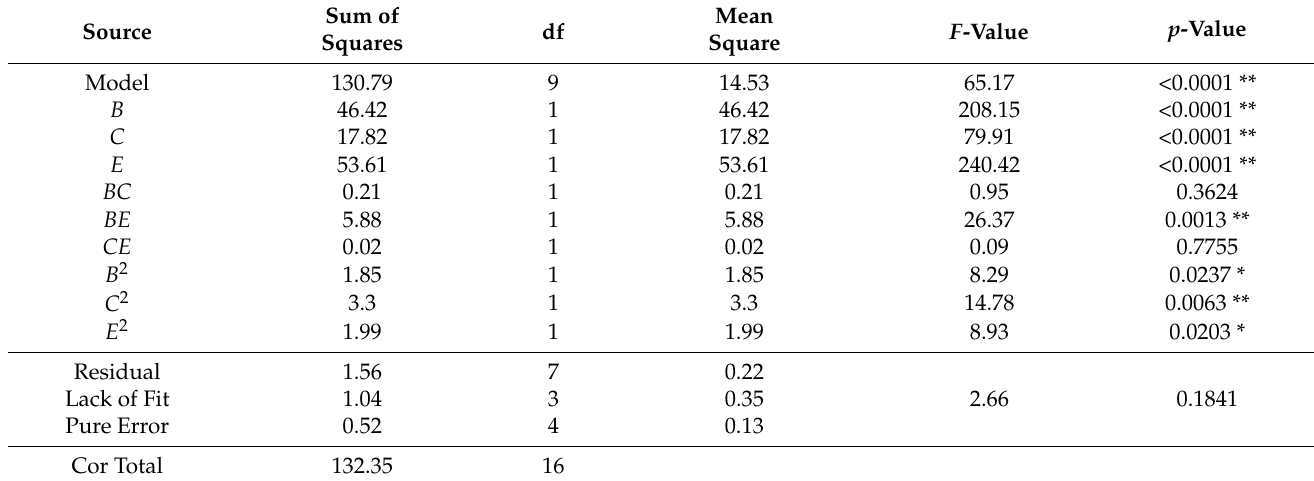
Table 7. ANOVA of the quadratic regression model in the Box–Behnken